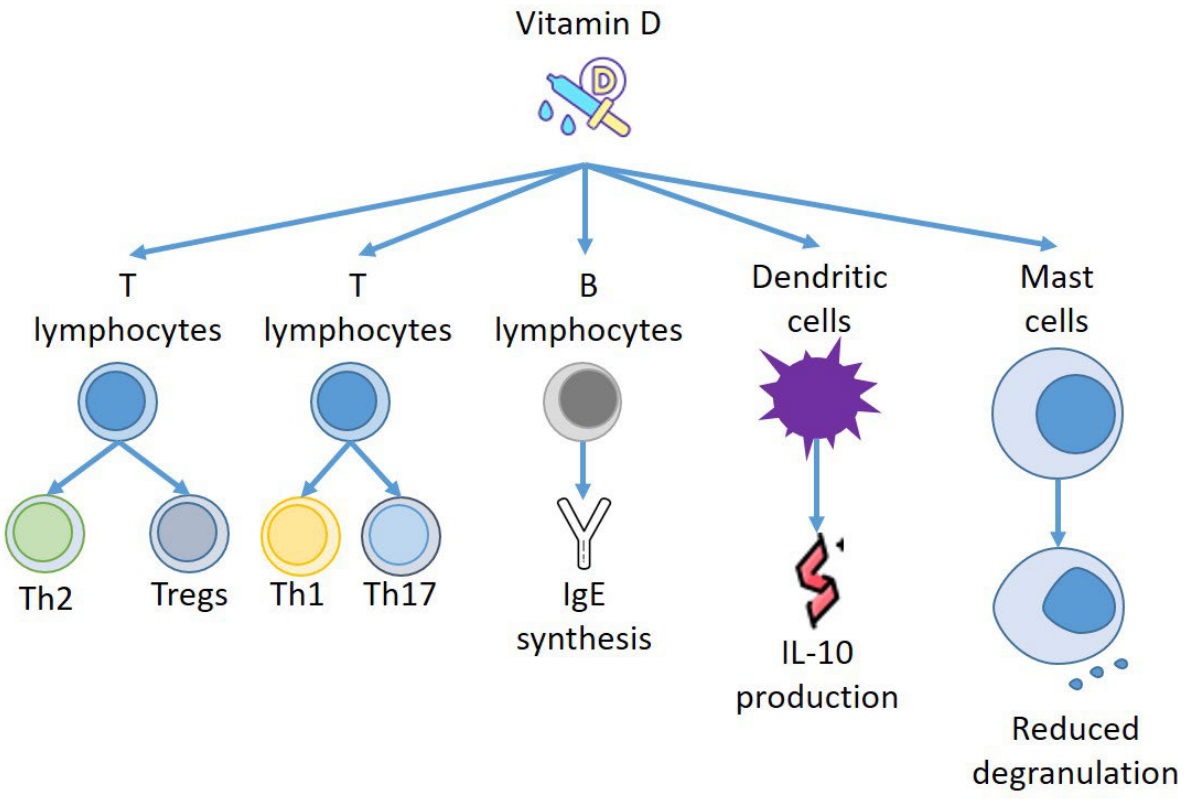
Figure 2. Effects of Vitamin D on immune